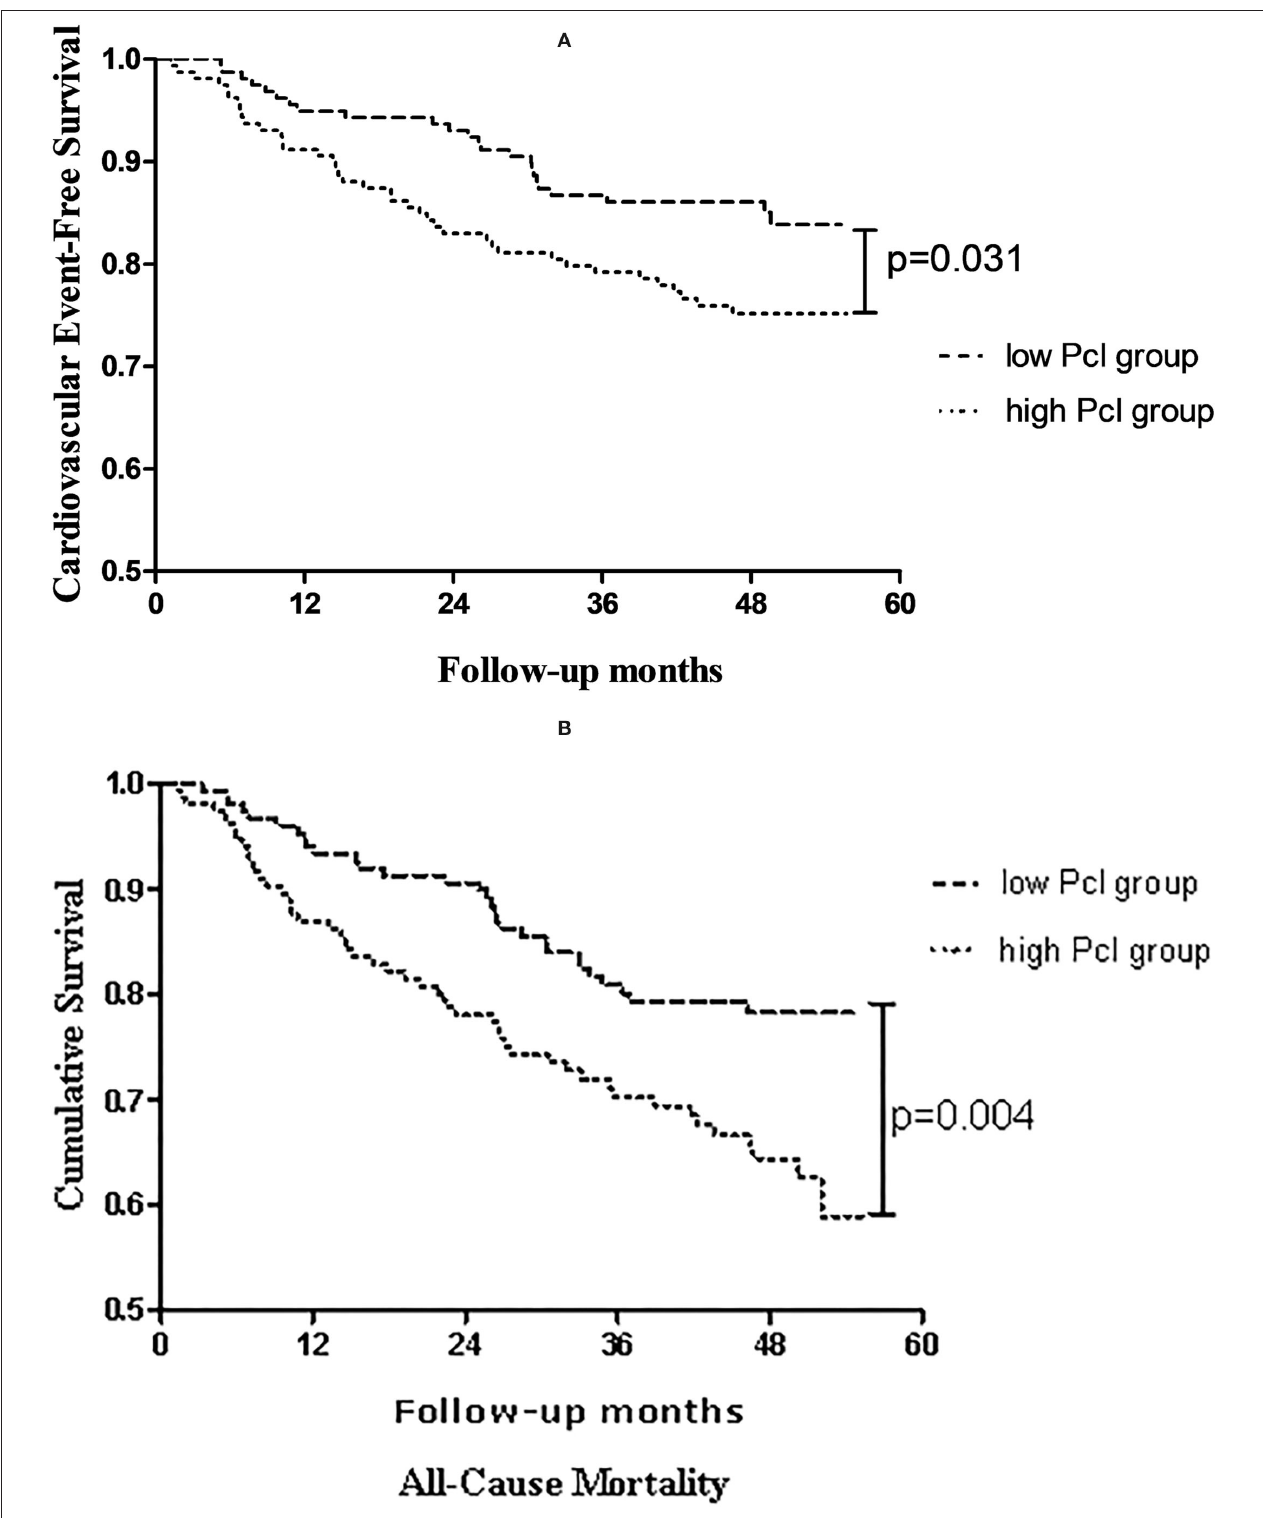
FIGURE 1 | Kaplan-Meier estimates of (A) cardiovascular events-free survival, (B) overall survival probability of patients stratified by dichotomization of peritoneal protein clearance.